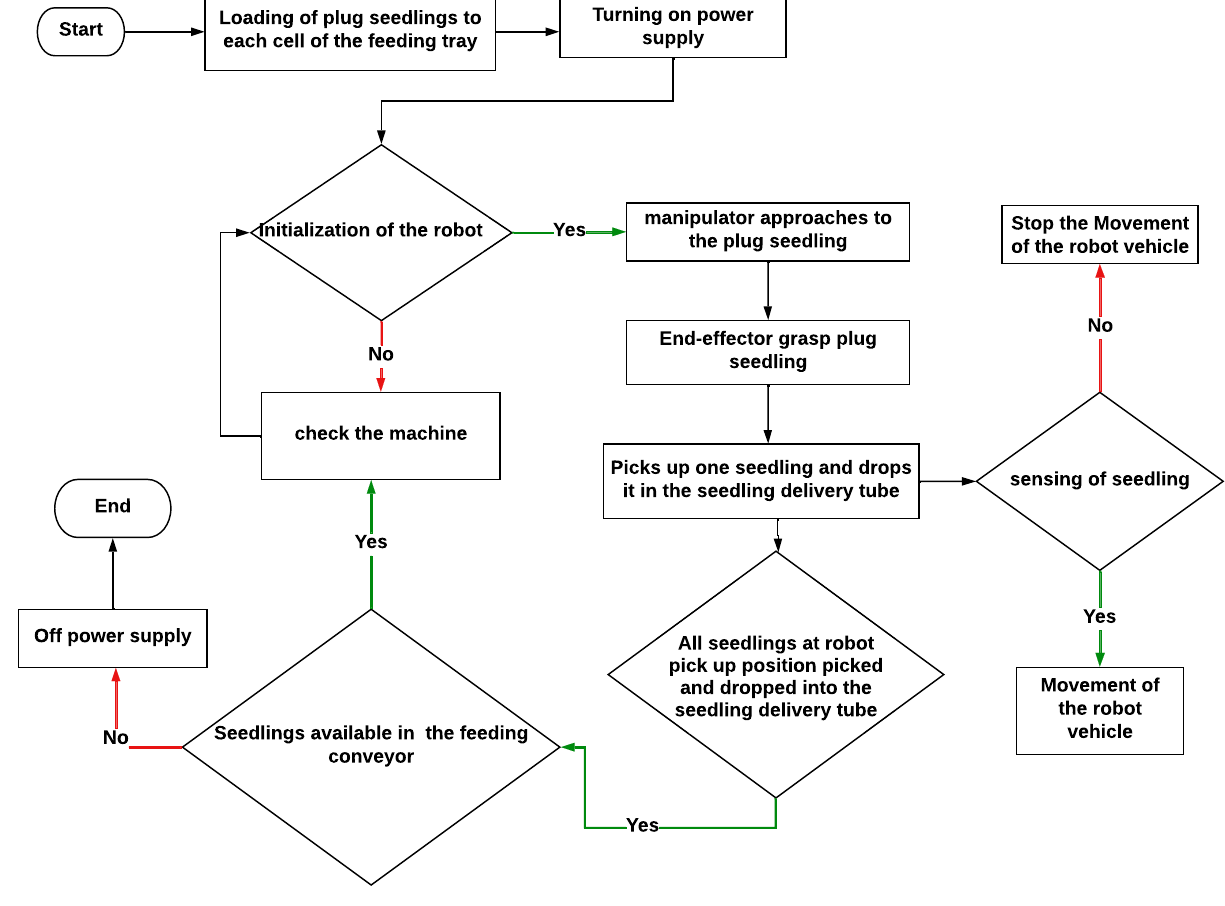
Figure 8. Flow chart of the overall control process of the robotic transplanter.